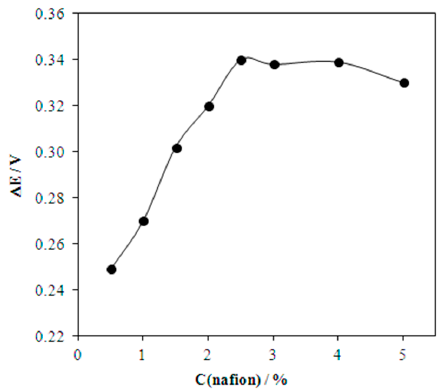
Figure 5. Effect of Nafion concentration on the difference of potentials of 0.1 mM UA and 0.5 mM AA oxidation at the Nf/Au(5nm)/ С SPE. Background: PBS ( рН 5), ν = 50 mV/s.